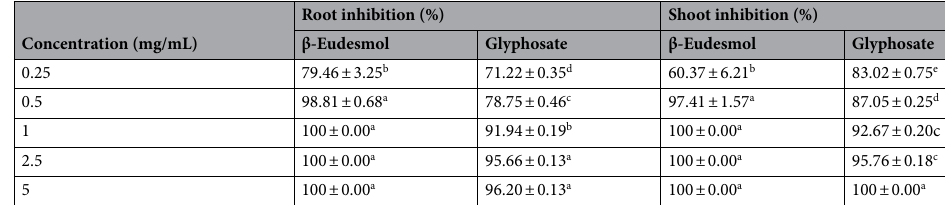
Table 6. Phytotoxic effect of β-eudesmol and glyphosate on seedling growth of A. retroflexus . a ± Standard error ( n = 30). b Different letters represent a significant difference at p < 0.05 level according to Fisher’s LSD test.